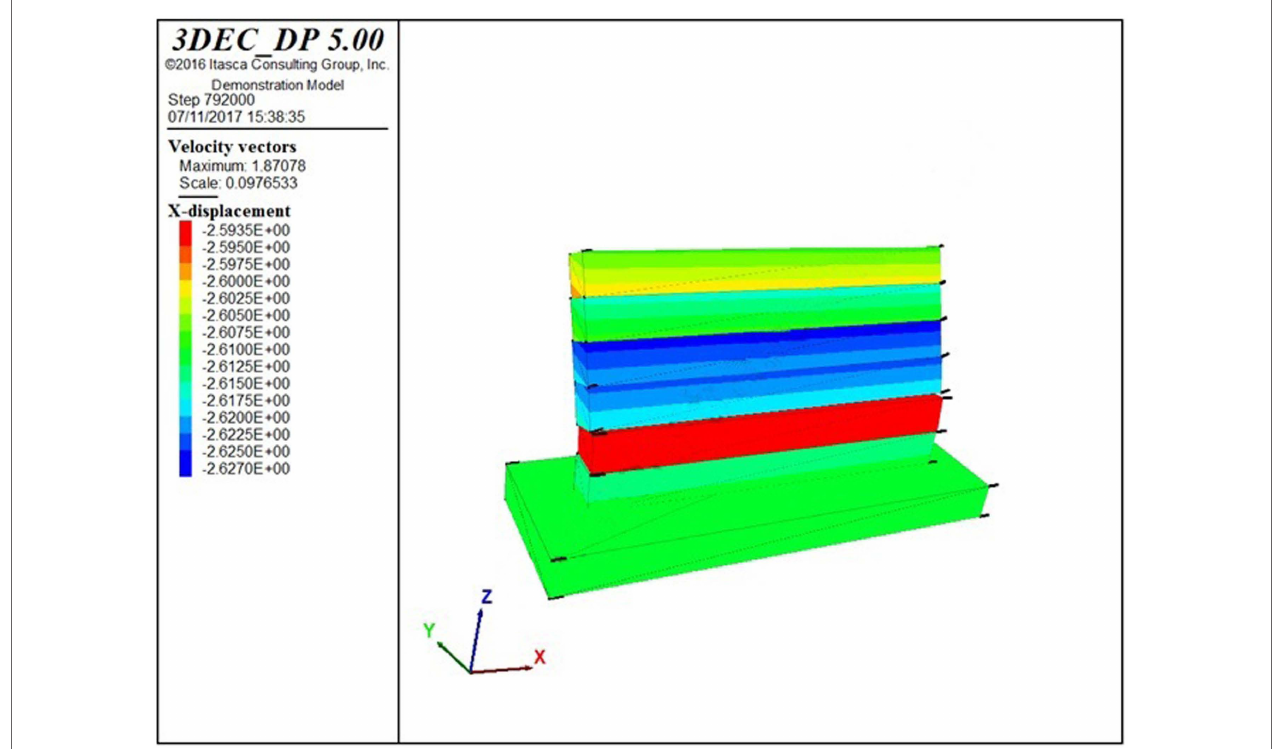
FIGURE 10 | Collapse mechanism for model I1 (activation acceleration = 0.48g).